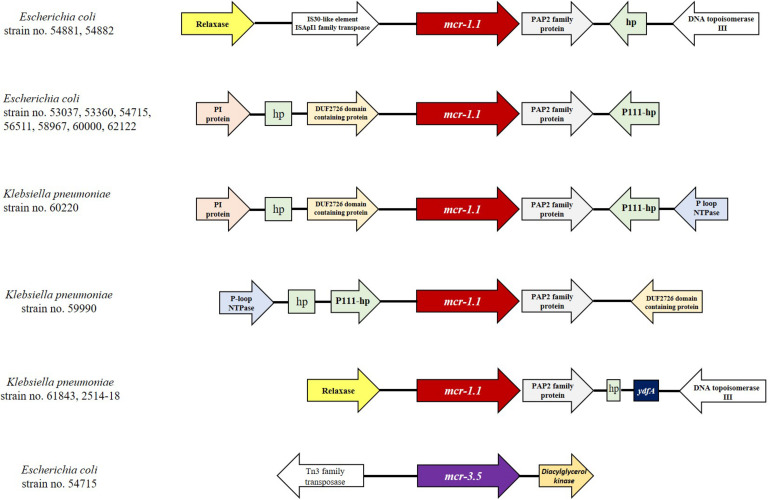
Comparison of the genetic organization of the mcr genes in 13 CRE isolates. The schematic shows the genes flanking the mcr genes in the isolates.